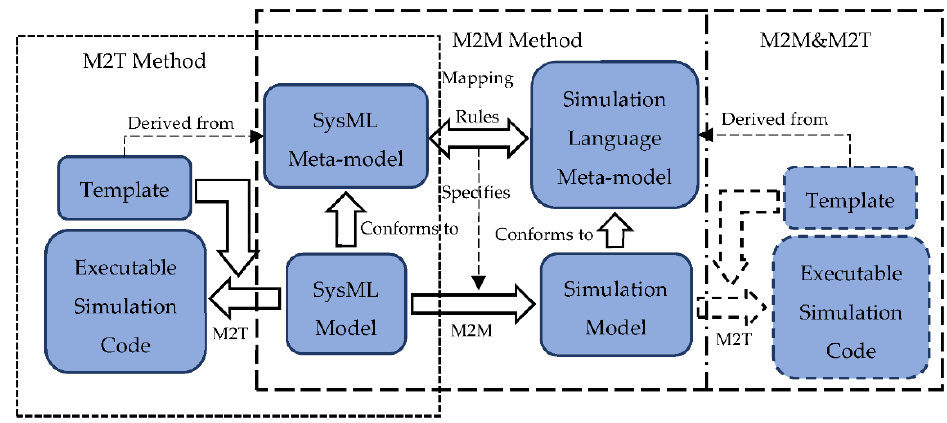
Figure 2. M2M and M2T transformation methods.